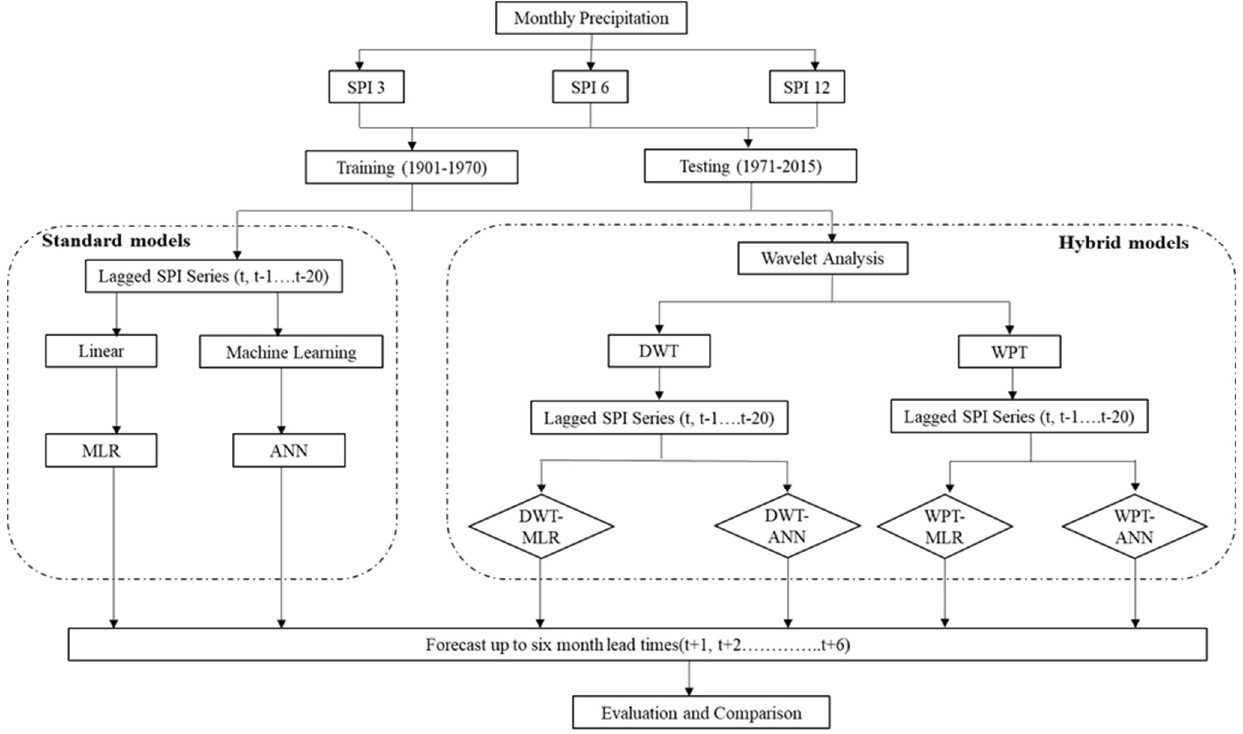
Figure 2. Overview of the methodology adopted in the present study. (SPI: Standard Precipitation Index, DWT: Discrete Wavelet Transform, MLR: Multiple Linear Regression, ANN: Artificial Neural Network, WPT: Wavelet Packet Transform).